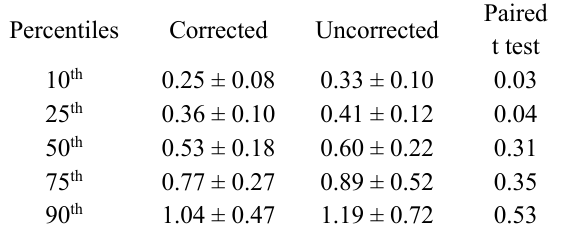
Table 4: Percentile Amplitude of Microsac- cade/Fixational saccades elicited in the right eye of sub- jects in corrected and uncorrected state during simple fixation task.